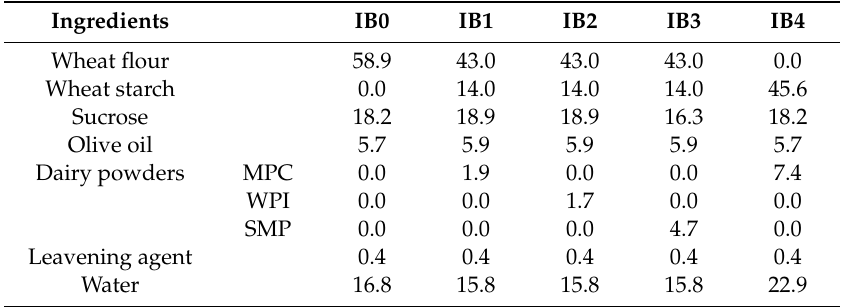
Table 1. Composition (g / 100 g) of experimental IBs. (MPC, milk protein concentrate; WPI, WP isolate; SMP, skimmed milk powder)